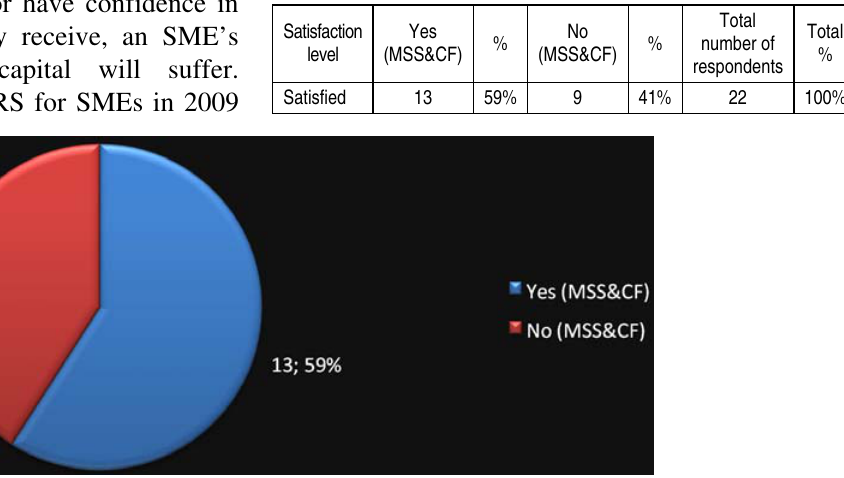
Fig. 6. Level of satisfaction from using IFRS for SMEs